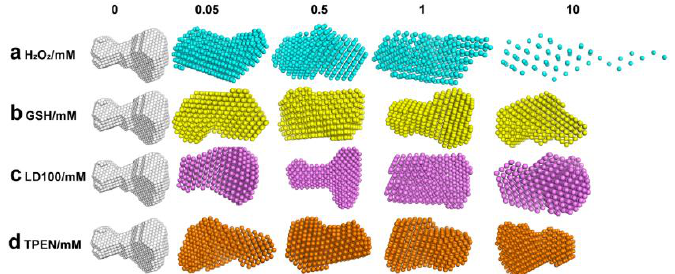
Figure 4. SAXS profiles of the dsDNA-SOD1 complex under varied redox conditions. Concentrations of 100 μ M SOD1 and 100 μ M dsDNA were incubated at 37 °C for 24 h in a 10 mM Ph 7.4 Tris-HCl buffer with H 2 O 2 , GSH, LD100, or TPEN (0, 0.05, 0.5, 1, 10 mM). Samples were centrifuged at 10,000 rpm at 4 °C for 10 minutes to remove possible aggregates before data collection.